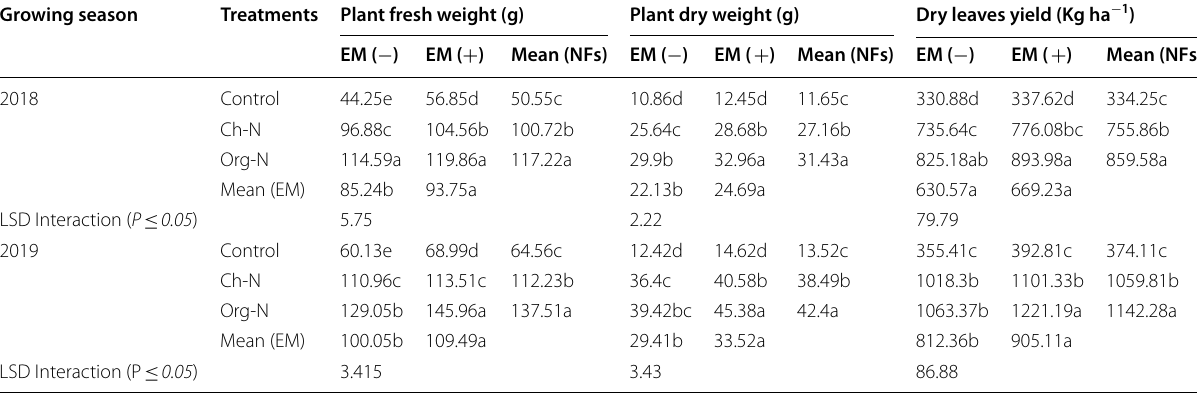
The values shown in table are means of two cuttings having four replicates. EM Effective microorganisms (biofertilizer), Ch - N Chemical-N form, Org-N Organic-N form, Means followed by the same letters are non-significantly different ( p